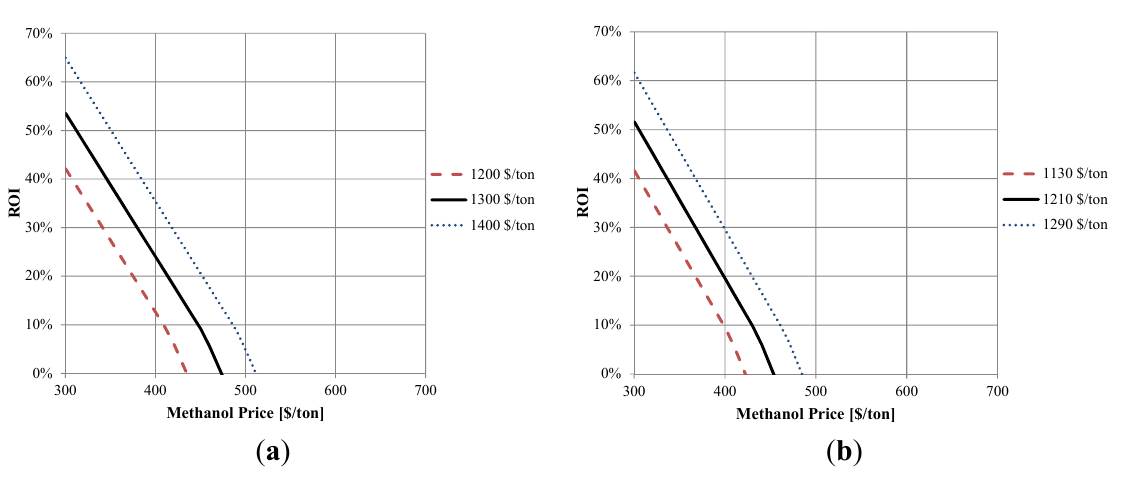
Figure 6. Sensitivity analysis for the ROI of MTO ( a ) and MTP ( b ) for product selling prices over a range of methanol purchased costs.